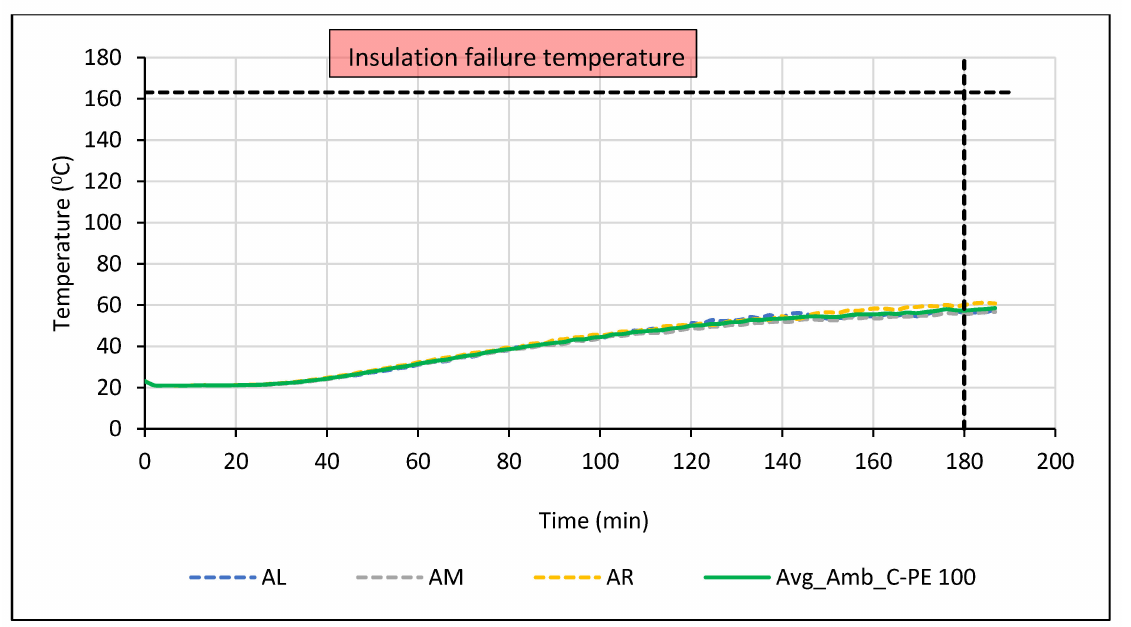
Figure 30. Ambient side surface time–temperature curves of C-PE 100 block from the building fire test.